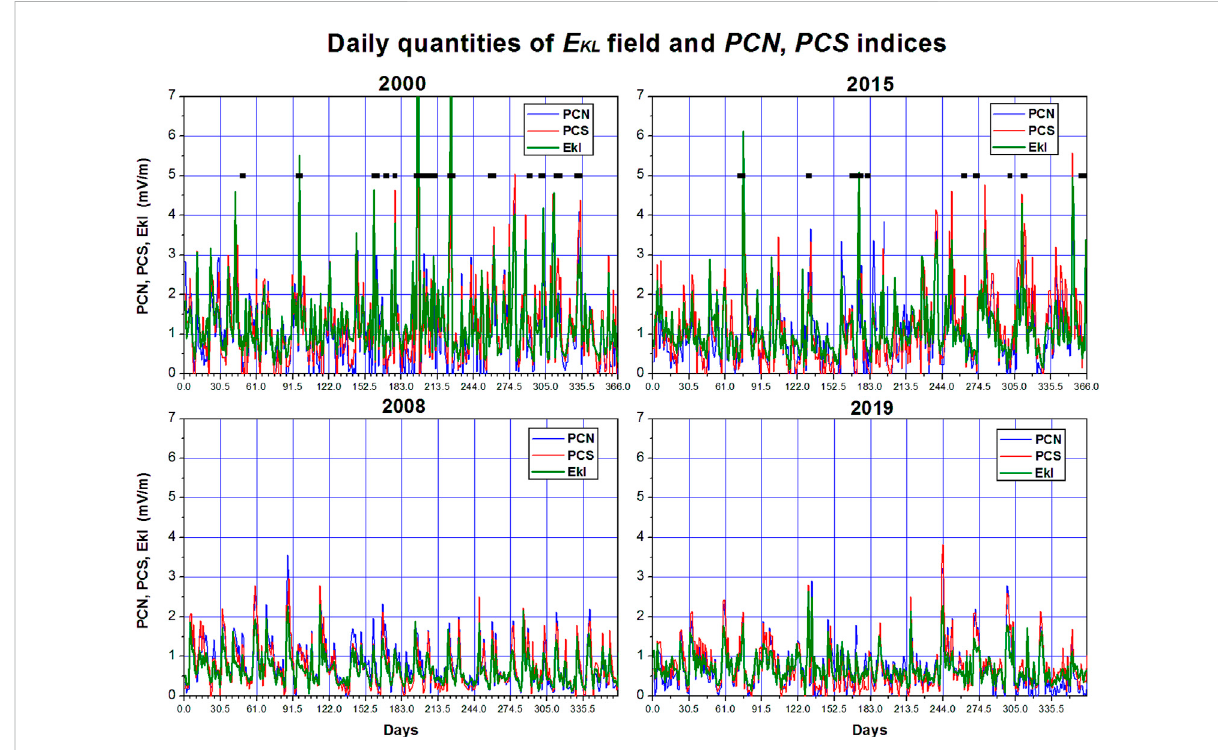
FIGURE 10 Coursesofthedailyquantitiesof E KL fi eldandde fi nitive PCN and PCS indicesinyearsofincreasedsolaractivity(2000,2015)andinyearsofsolar minimum (2008, 2019). Black strips mark days with SPEs (Troshichev et al.,